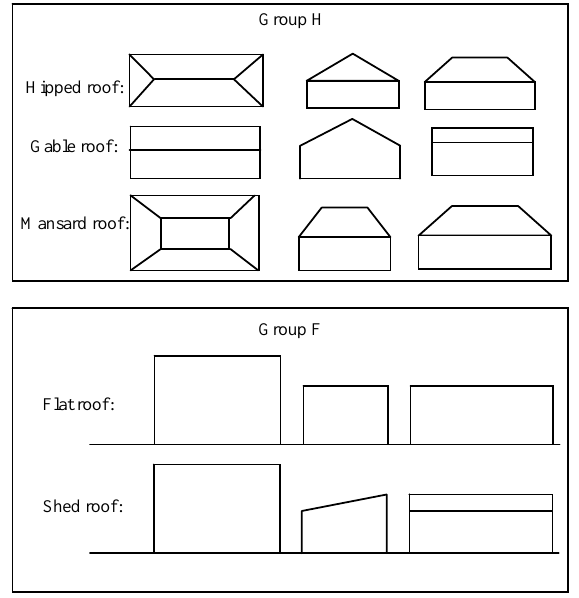
Figure 2. The library of roof primitives